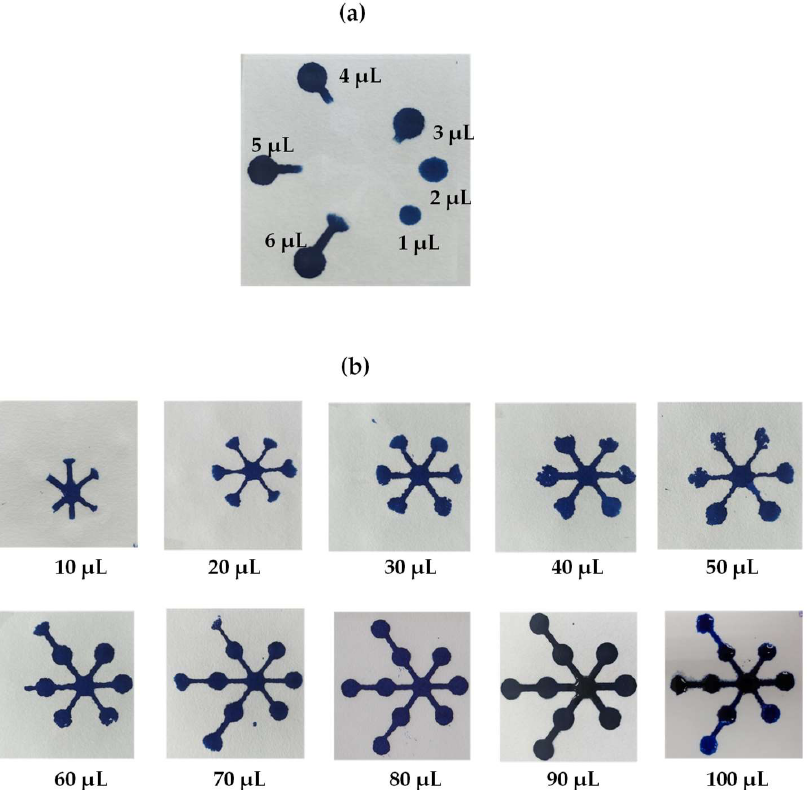
Figure 5. Effects of ( a ) the reagent volume on the detection zones and of ( b ) sample volume on the sample zones.